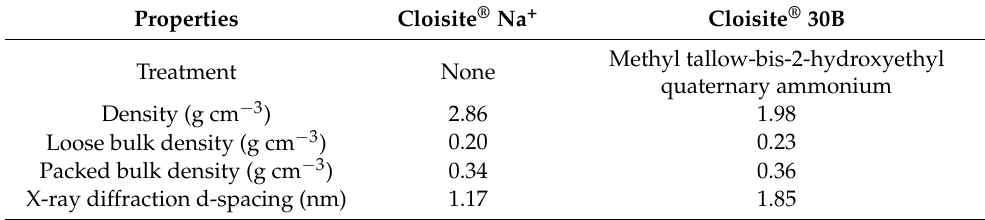
Table 3. Main characteristics of organomodified montmorillonite (Cloisite ® 30B) and natural sodium montmorillonite (Cloisite ® Na +